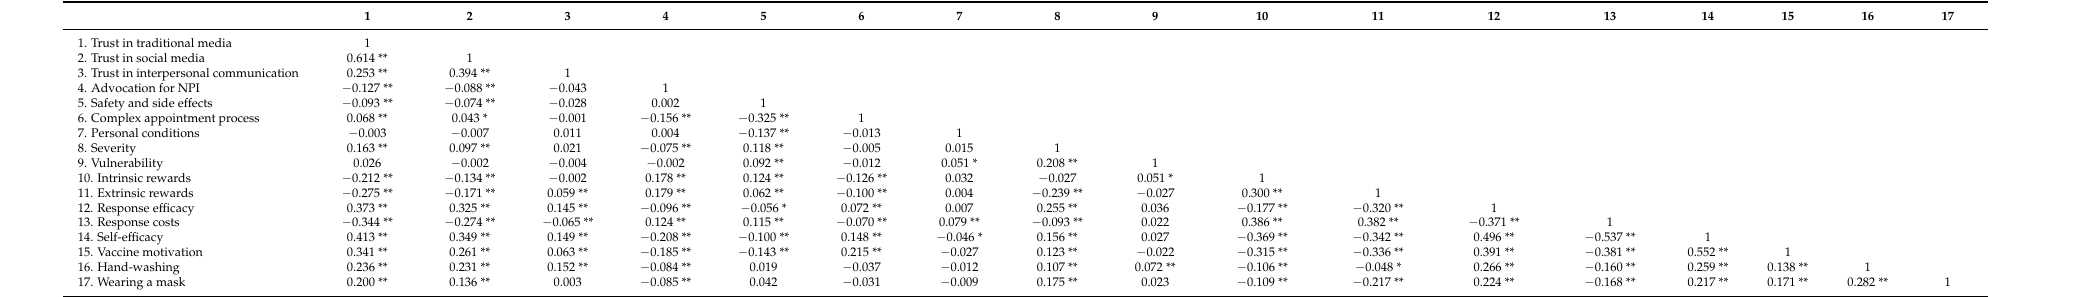
Table 4. Pearson correlation in the associations between studied